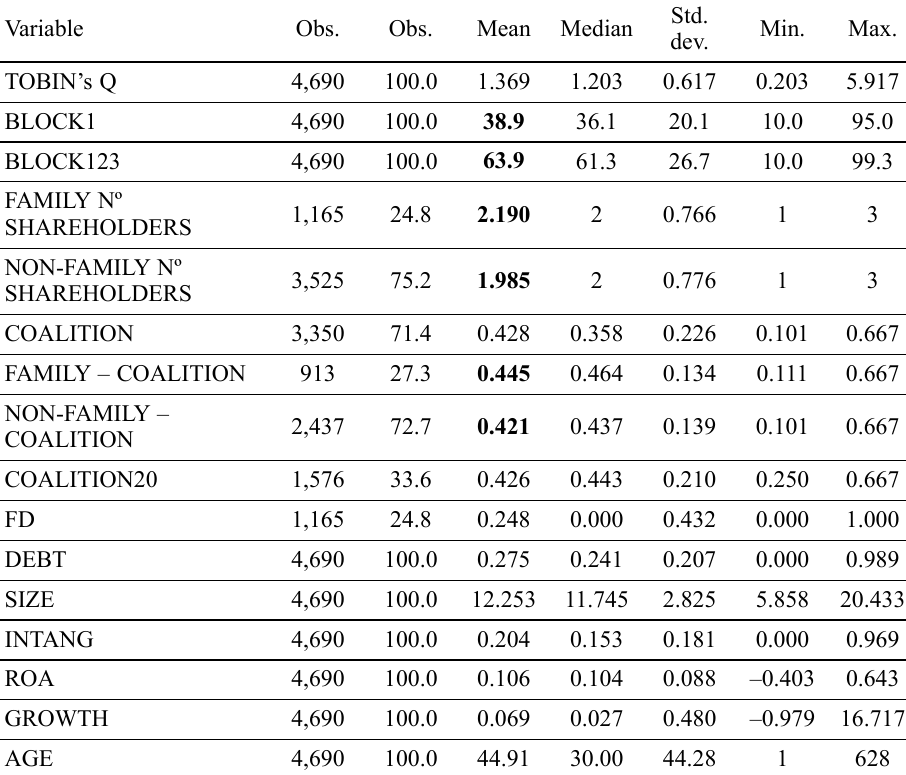
Table 2. Descriptive statistics for the main